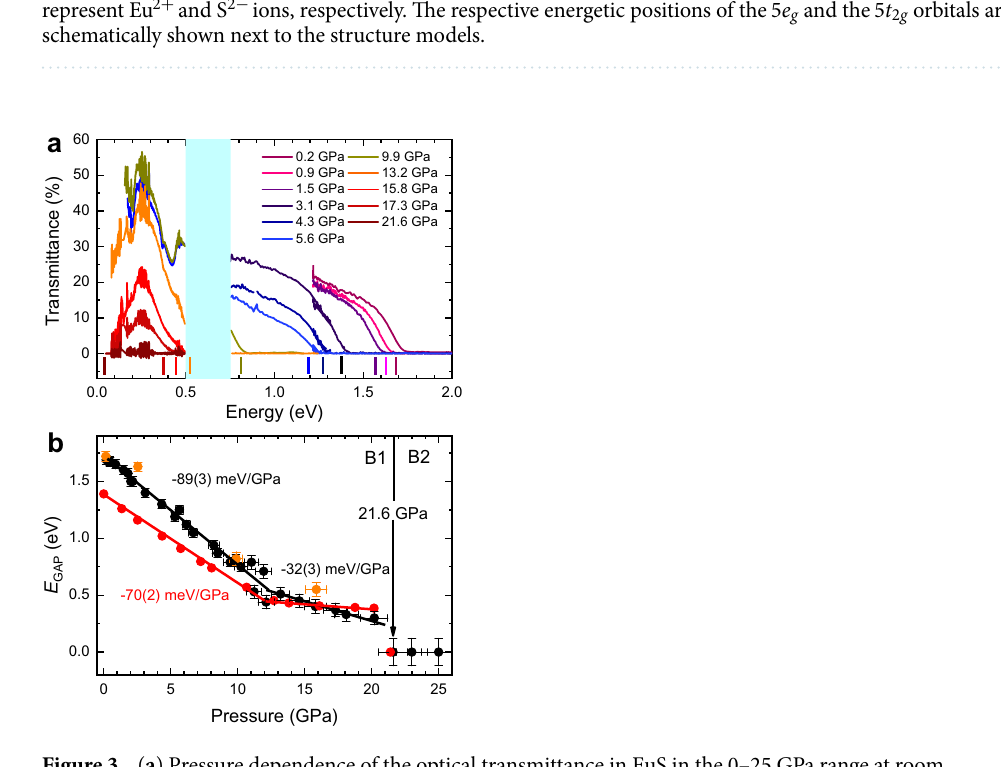
Figure 3. ( a ) Pressure dependence of the optical transmittance in EuS in the 0–25 GPa range at room temperature. The spectral range spans 0.05–0.5 eV and 0.74–3 eV. ( b ) Experimental up-stroke/downstroke (black/orange symbols) and calculated (red symbols) represent the direct band gap width at the X -point. Lines are guides to the